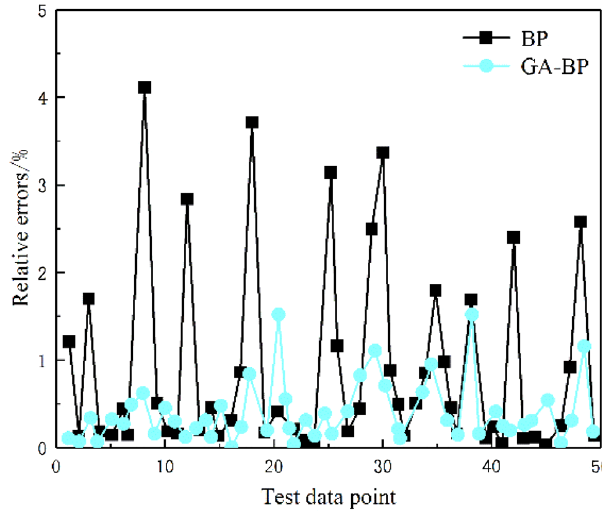
Figure 6. The prediction errors of the two models’ test sample.